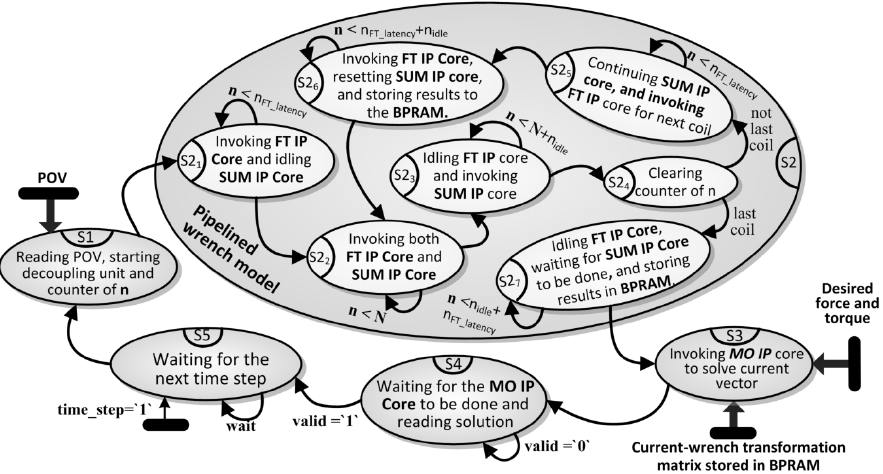
Figure 5. Finite-state machine of current decoupling based on numerical wrench model and matrix